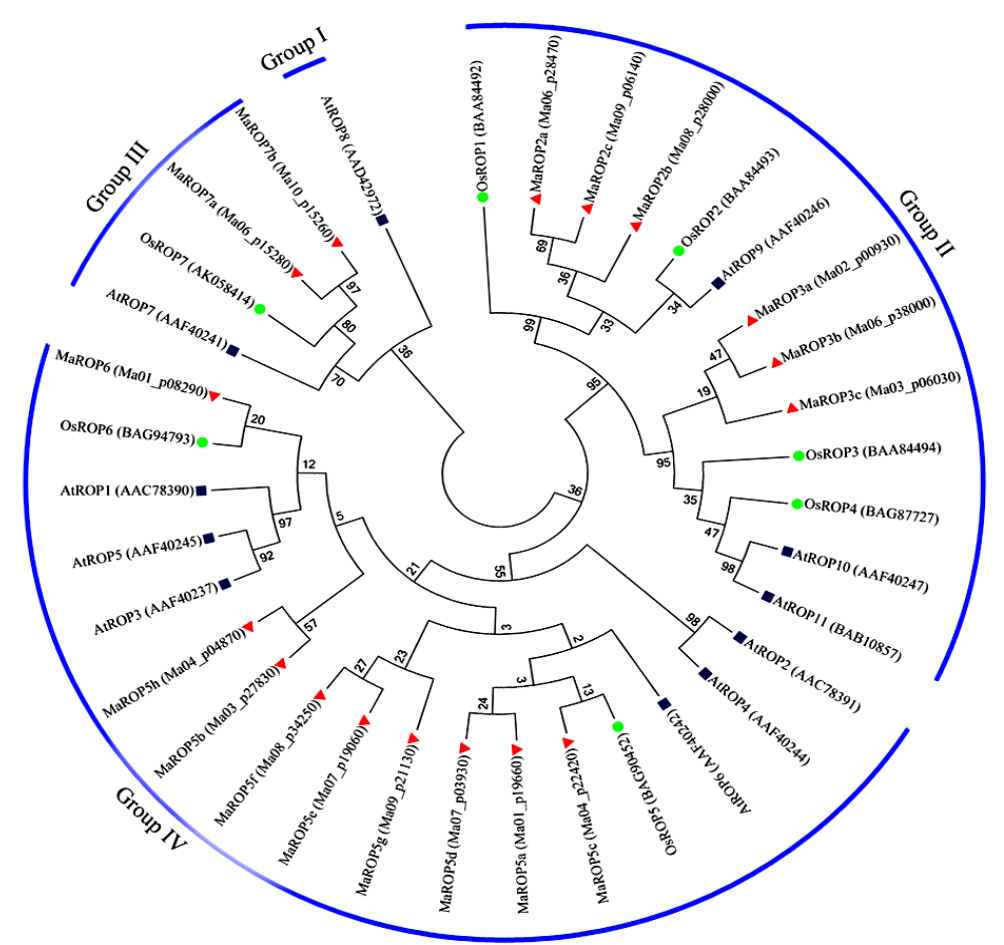
Figure 1. Phylogenetic analysis of Rho-like GTPases from plants (ROPs) from A. thaliana , rice, and bananas. The maximum-likelihood phylogenetic tree was drawn with MEGA5.2, using 1000 bootstraps. Four subgroups were identified (Groups I–IV). Circles, squares, and triangles represent ROP proteins from rice, A. thaliana , and bananas, respectively.